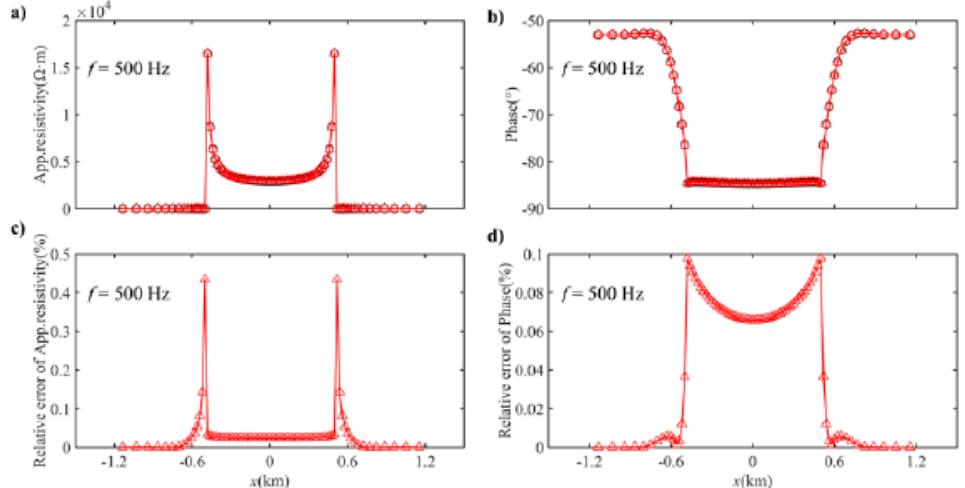
Figure 8. Comparison plots of the apparent resistivity ( a , c ) and phase ( b , d ) from the case based on the quasi-static approximation (upward-pointing triangle lines)) with 10 − 6 S / m for air conductivity, and the one with the complete wavenumber (circle lines) at a frequency of 5 × 10 2 Hz for the canyon model. The relative errors are referenced to the results based on the use of the complete wavenumber.